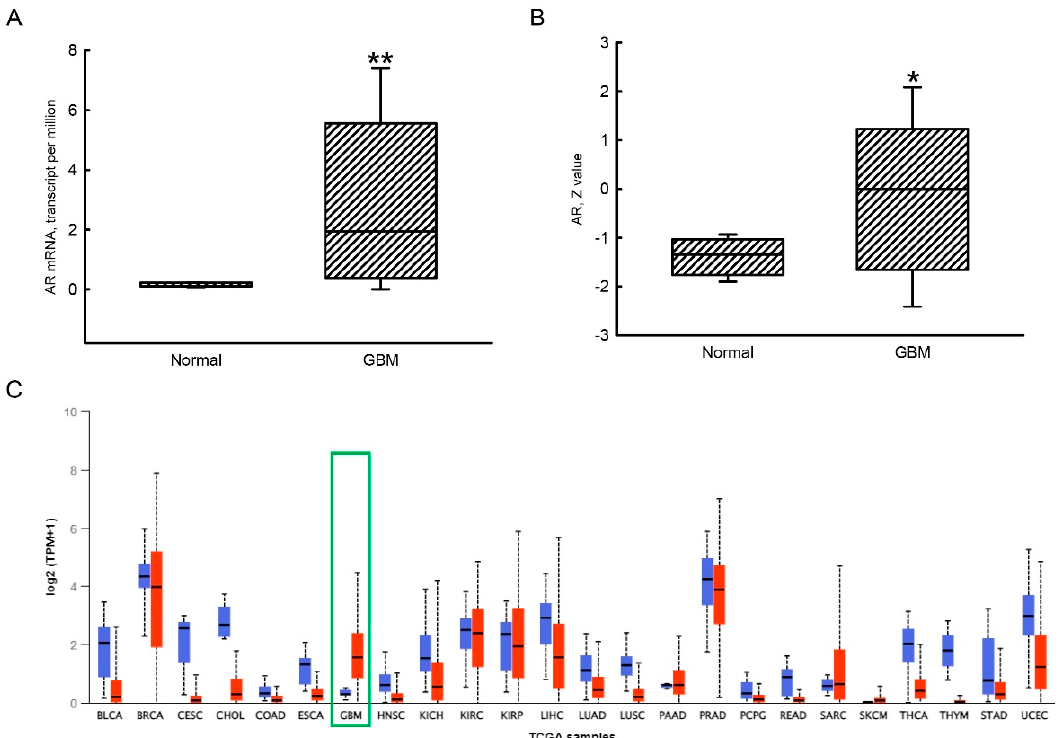
Figure 1. Upregulation of androgen receptor (AR) mRNA and protein expressions in human glioblas- toma multiforme (GBM) tissues. Differential expressions of AR mRNA in normal ( n = 5) and GBM ( n = 156) tissues were mined from The Cancer Genome Atlas (TCGA) database and analyzed using UALCAN (http://ualcan.path.uab.edu/ (accessed on 6 June 2022).) ( A ). Protein expressions of the AR in normal ( n = 10) and GBM ( n = 99) tissues were extracted and analyzed using UALCAN ( B ). Expressions of the AR gene across TCGA cancers are shown ( C ). The red boxplot indicates expression levels in primary tumors, while the blue boxplot designates expressions in normal samples. Each value represents the minimum, lower quartile, median, upper quartile, and maximum. The symbols * and ** indicate the values significantly differ from the respective normal group, * p < 0.05, ** p < 0.01. The GBM is highlighted with a green